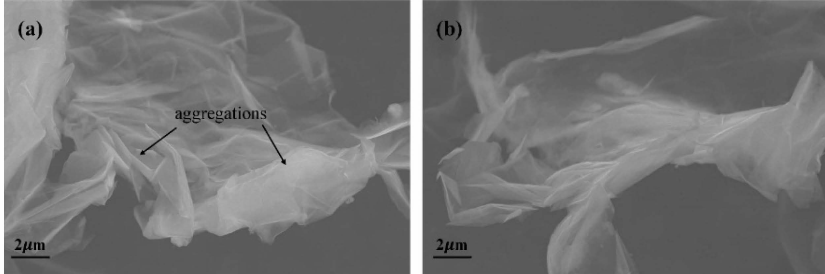
Figure 2. Scanning electron microscope (SEM) images of ( a ) GO and ( b )